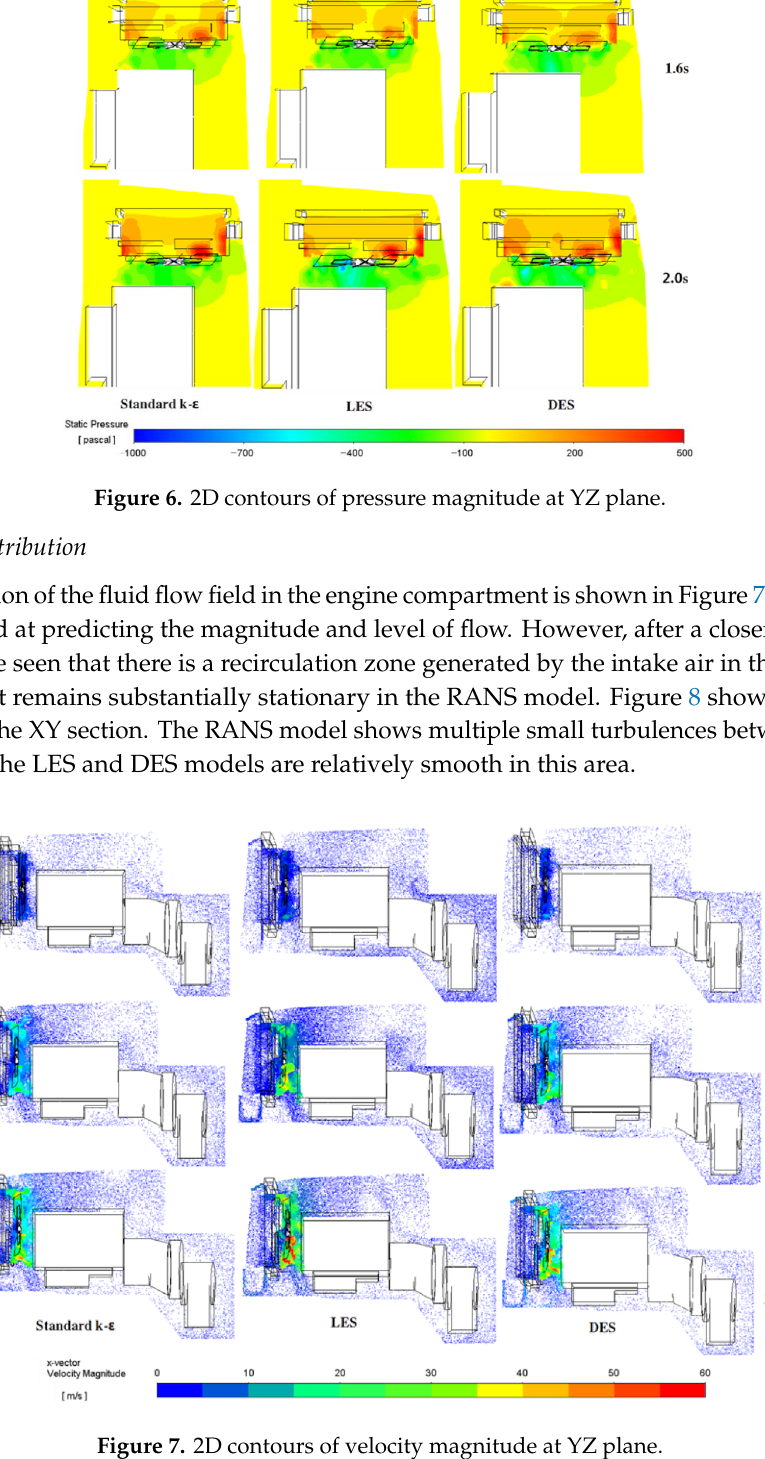
Figure 7. 2D contours of velocity magnitude at YZ